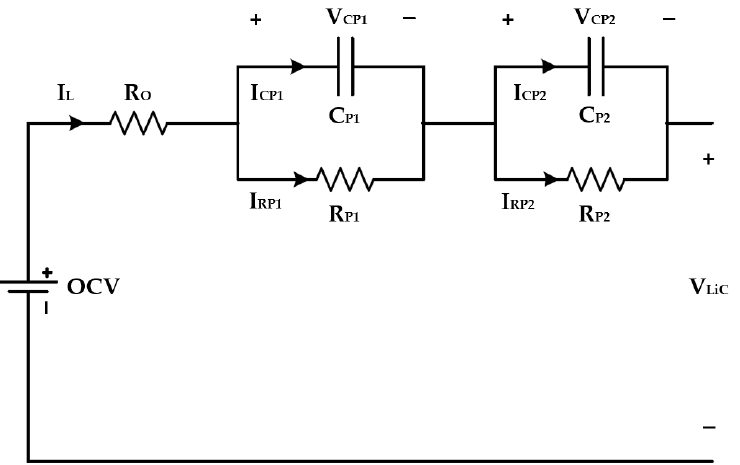
Figure 4. Schematic of the second-order semi-empirical equivalent circuit model.